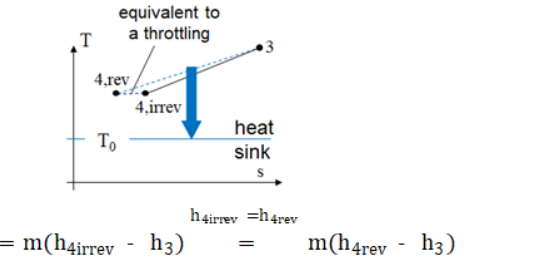
Figure 4. Irreversible heat output is equalizing the reversible one, constant pressure cooling.